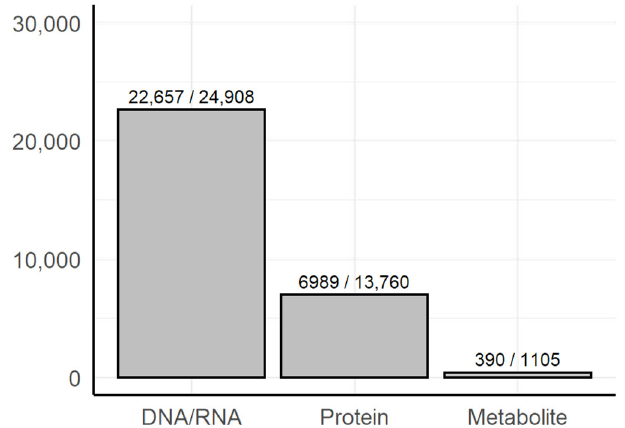
Figure 8. Results of the automated review of all included text fragments in each dictionary-defined category. The total numbers of the text fragment in the dictionary-defined categories are given after the slash.